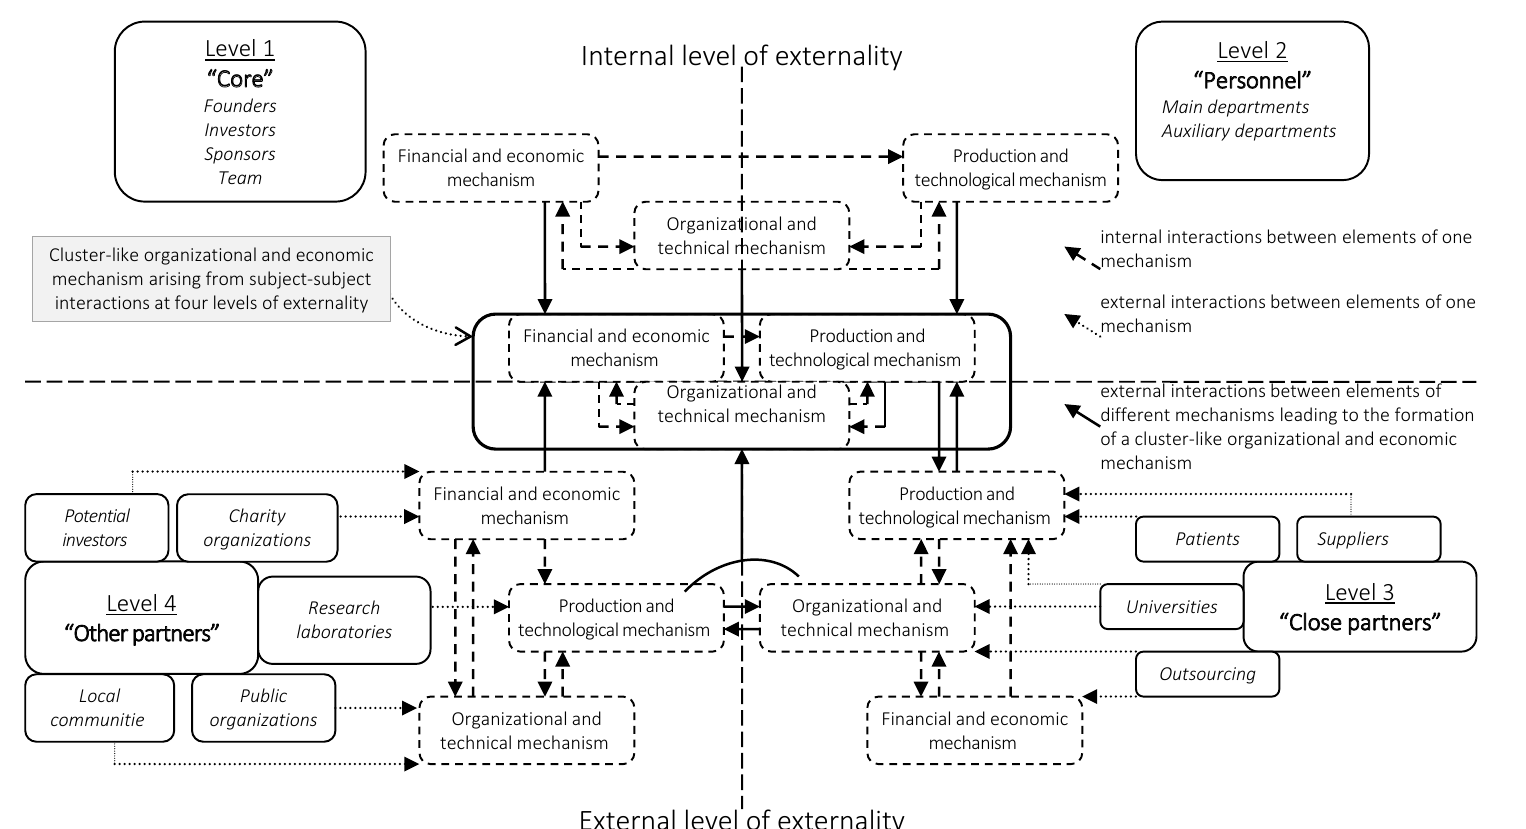
Figure 3. Subject-subject interactions at four levels of externality for healthcare